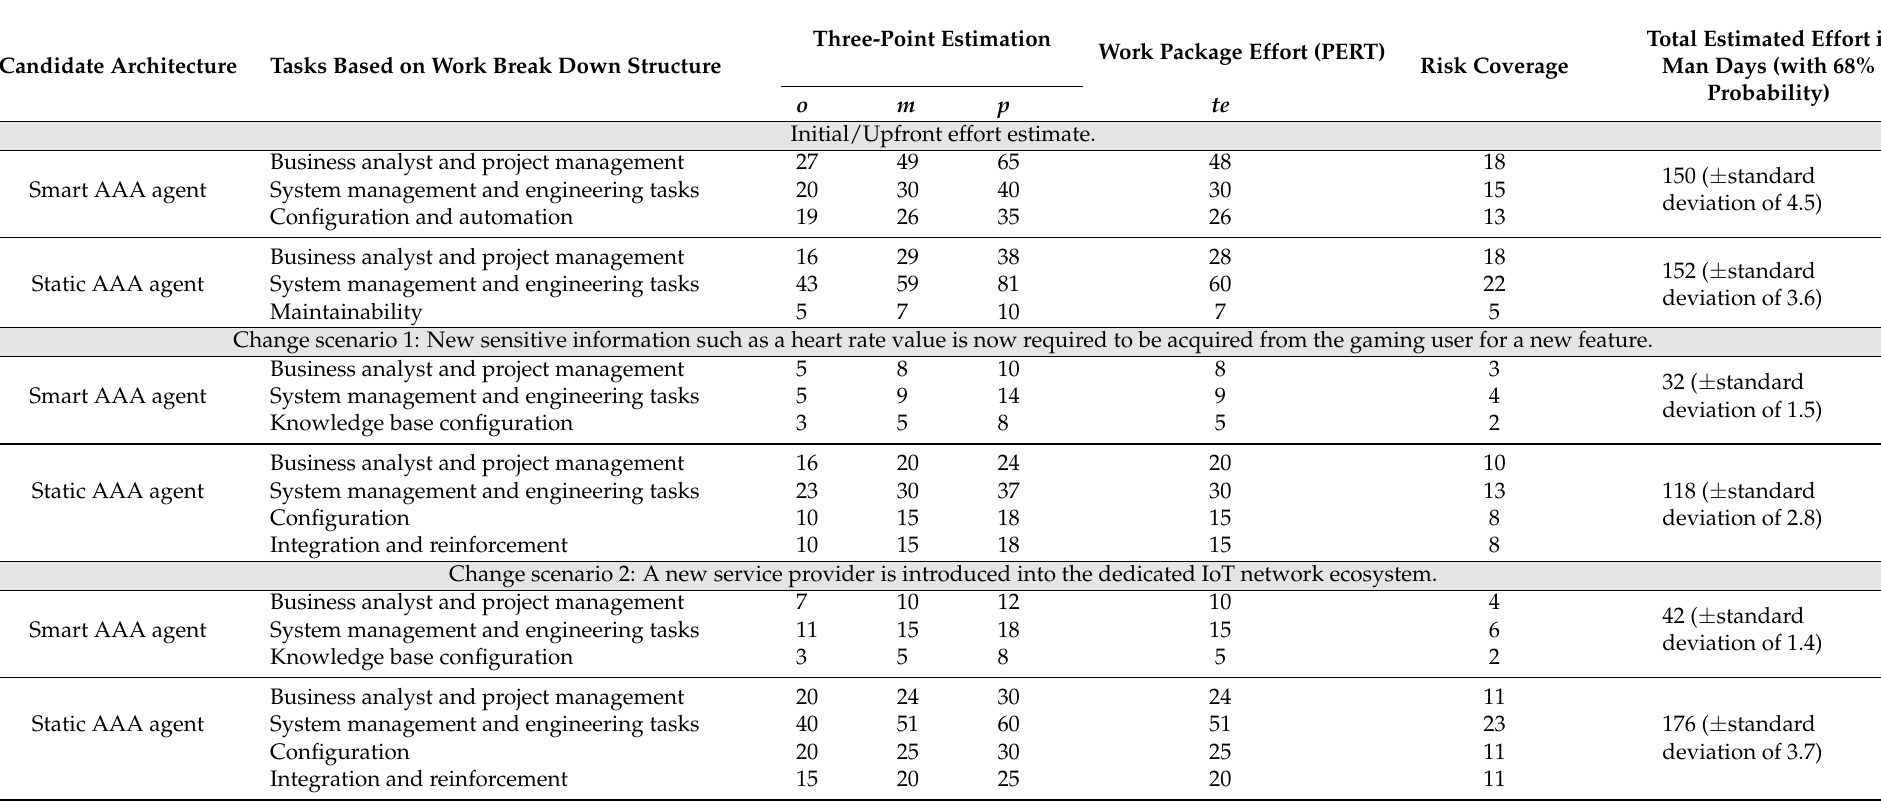
Table 3. Effort estimation in man days of the initial setup and the two change scenarios for the smart AAA agent and the static AAA agent.